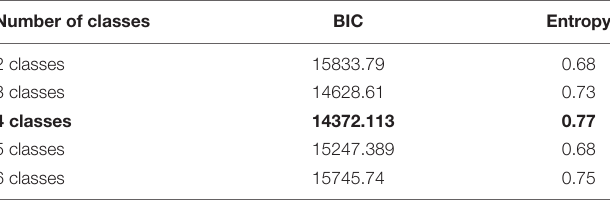
TABLE 3 | Fit indices of the LCA values in bold revealing the best model fit.